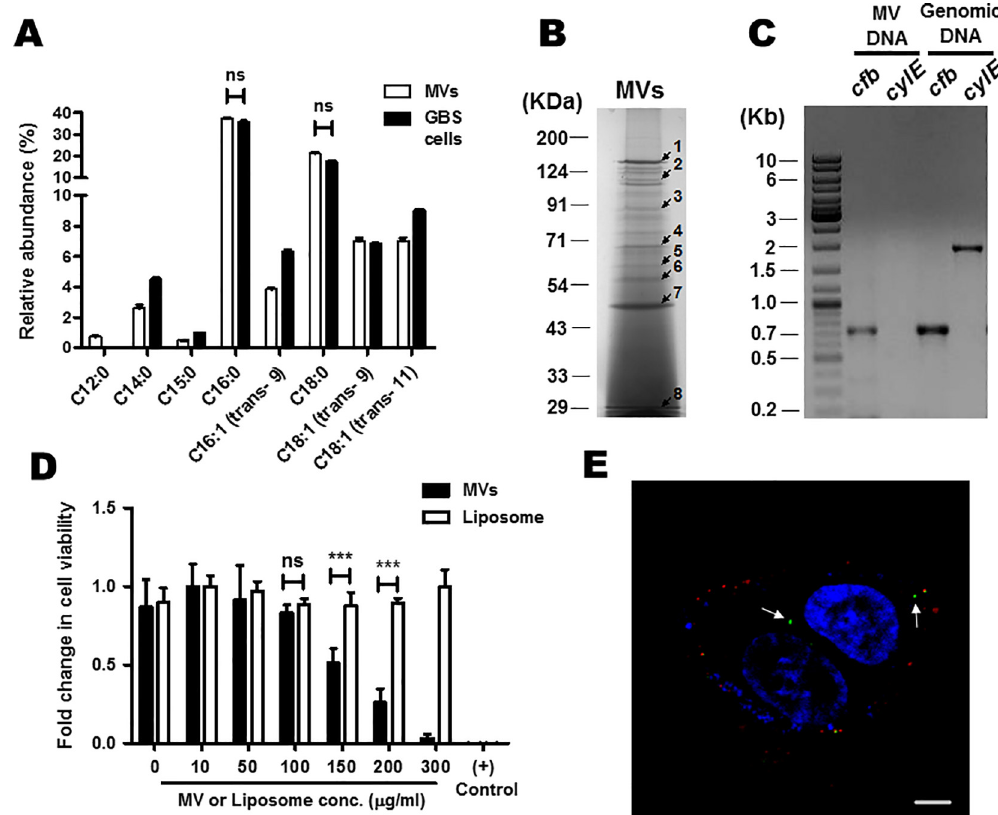
Fig 2. Characterization and biological activity of membrane vesicles isolated from GBS strain A909. A. Relative abundance of different fatty acids in MVs and whole bacterial cells analyzed using a GC-MS. Compounds were identified by comparison of the mass spectra with a library. Total fatty acids and other small molecules found in intact GBS cells were considered as 100% and the relative amounts of the same for MVs were calculated accordingly. Experiments were performed thrice. Statistical analysis was performed using two-way ANOVA (Bonferroni test); ns, non-significant. B. SDS-PAGE of proteins packaged in MVs. 150 μ g of MV protein was precipitated with TCA (10%) and separated on 12% SDS-PAGE. Selected protein bands (indicated by arrow) were excised from the gel, trypsinized and the resulting peptides were analyzed by MALDI mass spectrometry